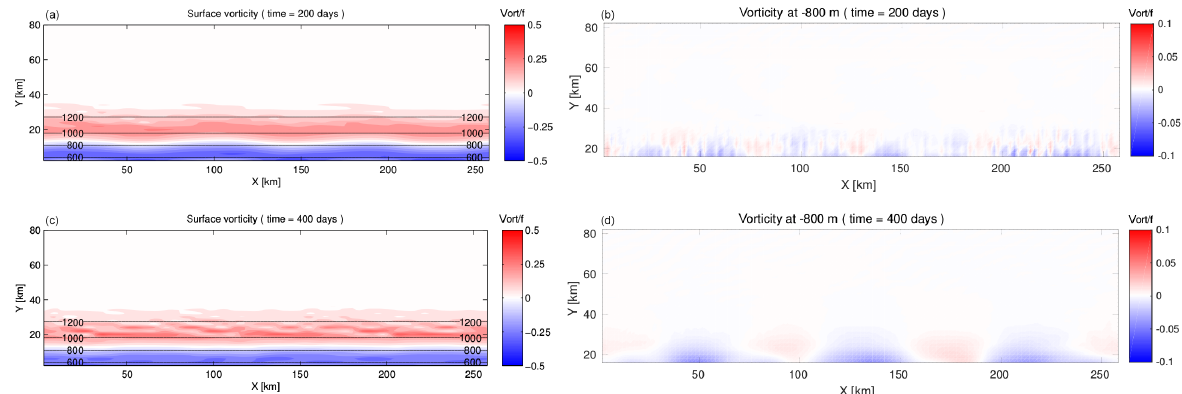
Figure 5. The relative vorticity ( ζ/f ) at the surface (left panel) and in the deep layer at z = − 800m (right panel) for a shelf slope ( s = 3%, T p = − 0 . 41) when the aspect ratio parameter is γ (cid:39) 0 . 45 ( H = 800m) and the vortex Rossby number is Ro = 0 . 25. The colour bar of the lower layer is magnified by a factor of 5 in comparison with the upper layer. Panels (a, b) and (c, d) correspond to t = 200 days and t = 400 days,